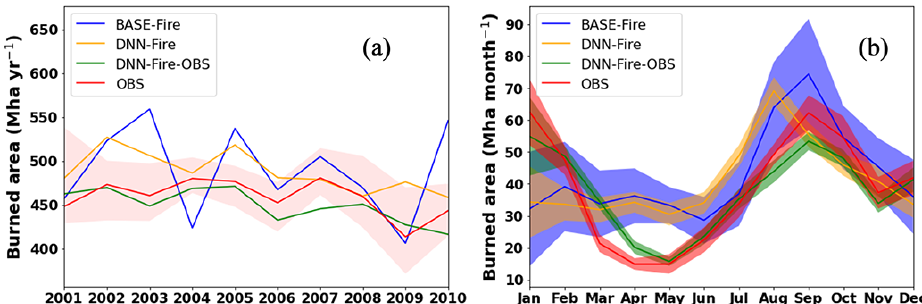
Figure 5. Inter-annual variation of burned area from years 2001 to 2010 (a) and the averaged seasonal cycle (b) of burned area estimated by the ELMv1 process-based wildfire model (BASE-Fire), deep neural network wildfire model (DNN-Fire), deep neural network wildfire model fine-tuned with observations (DNN-Fire-OBS), and observations.